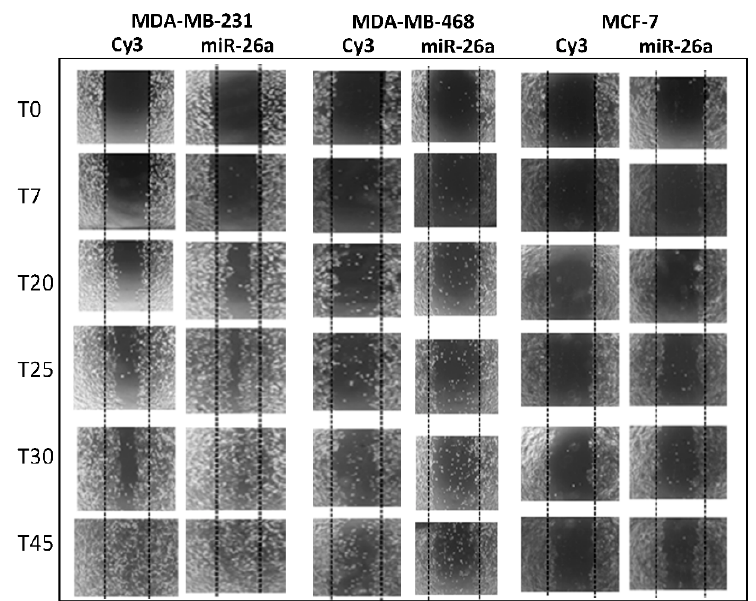
Figure 3. Wound healing cell migration assay comparing cells transfected with 50 nM miR-26a or CY3 (control). Cells transfected with miR-26a closed the wound before the CY3-transfected cells (24 vs. 30 h).